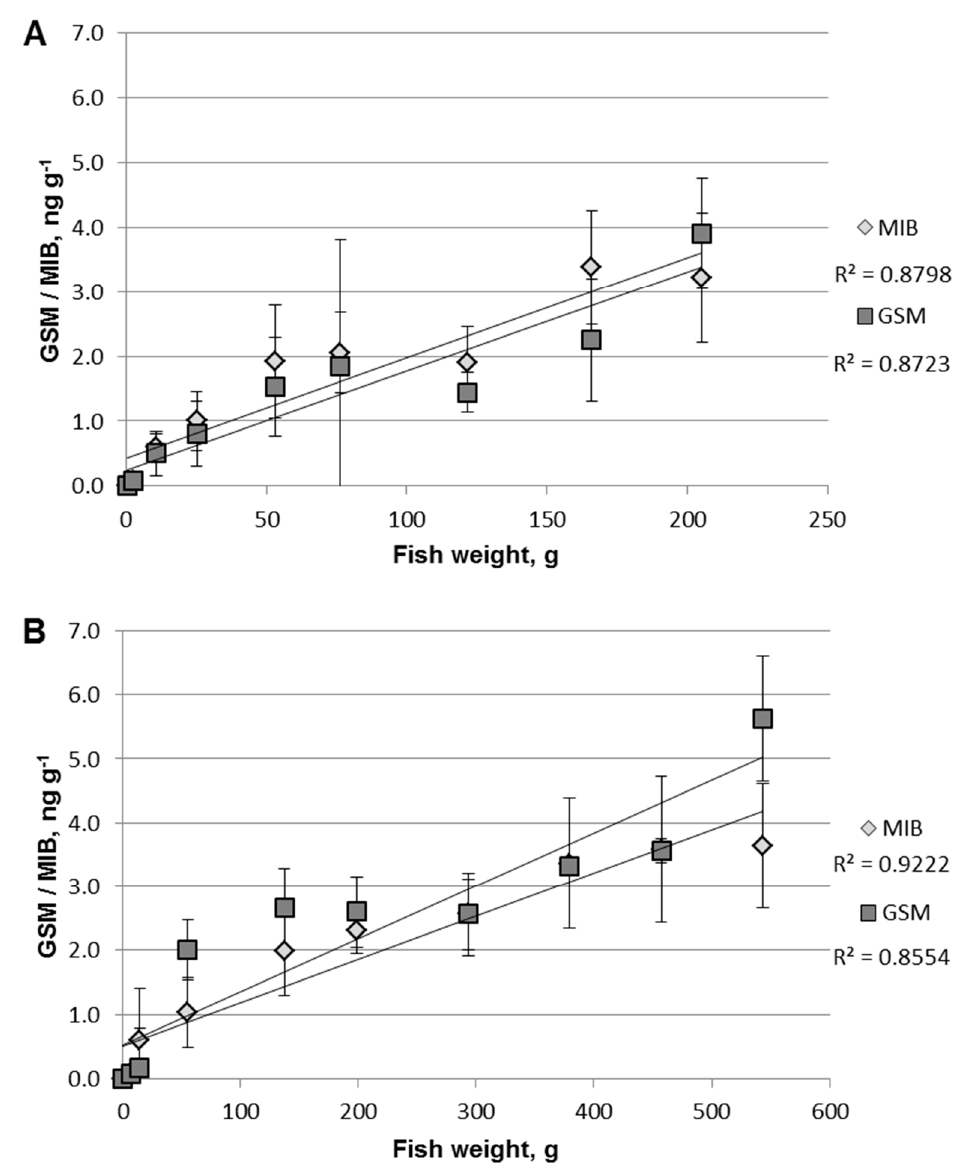
Figure 2. Concentrations of GSM and MIB (ng · g − 1 , n = 4, ± SD) in European whitefish ( A ) and in rainbow trout ( B ) vs. weight (g) during the experiment.